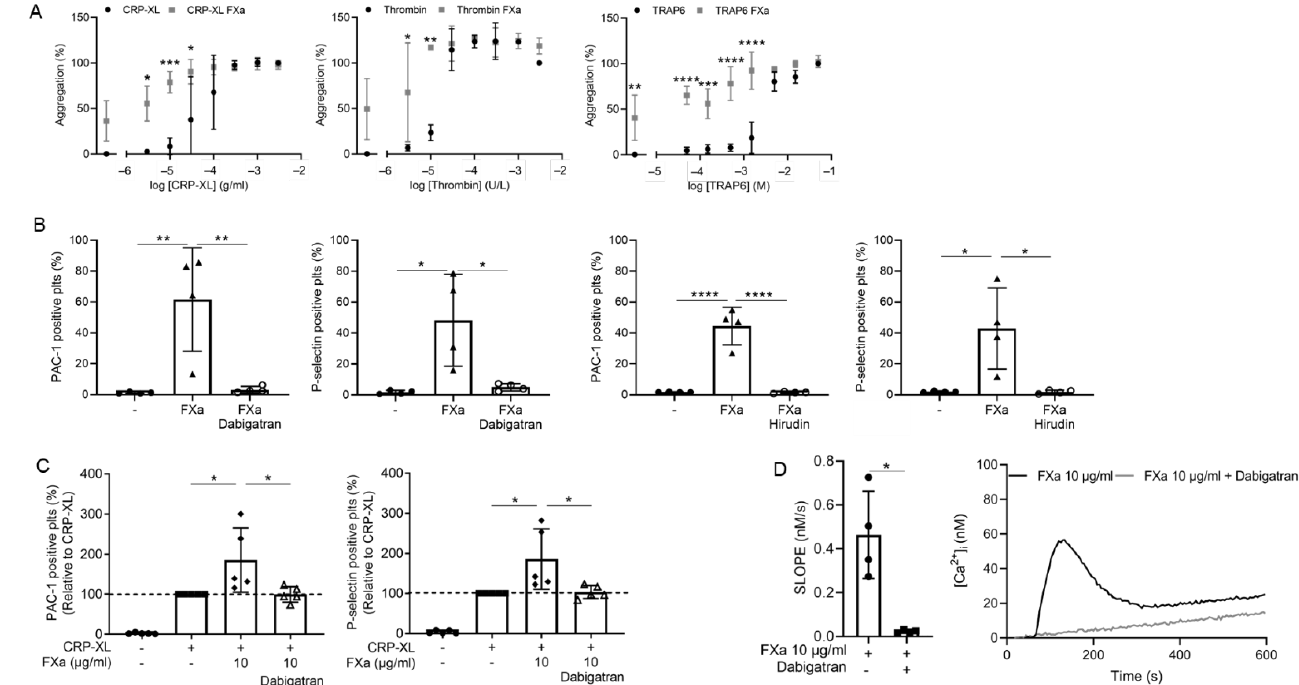
Figure 2. Factor Xa induces platelet activation and enhances agonist-induced platelet effects, in a thrombin-dependent way. ( A ) Factor Xa enhances agonist-induced platelet aggregation. Washed platelets preincubated with vehicle or FXa (10 µ g/mL) were stimulated with CRP-XL (0.003–3 µ g/mL), thrombin (0.003–3 U/mL) or TRAP-6 (0.05–50 µ M). Platelet aggregation was assessed by well plate-based light transmission changes. All data were scaled relative to aggregation obtained upon highest agonist concentration in the presence of vehicle (100%). Mean ± SD, n = 3; two-way ANOVA, * p < 0.05, ** p < 0.01, *** p < 0.001, **** p < 0.0001. ( B ) FXa-induced platelet activation is inhibitable by dabigatran or hirudin. Flow cytometry, washed platelets. Active integrin and P-selectin expression are shown. Percentage positive platelets. One-way ANOVA, multiple comparisons, mean ± SD, n = 4 – 5, one-way ANOVA, * p < 0.05 and ** p < 0.01, **** p < 0.0001. ( C ) Enhancement of CRP-XL-induced platelet activation by FXa is abolished by dabigatran. One-way ANOVA, multiple comparisons, data are compared to CRP-XL, * p < 0.05, mean ± SD, n = 4 – 5. ( D ) FXa-induced cytosolic Ca 2+ release is inhibitable by dabigatran. Washed platelets, loaded with Fura-2 acetoxymethyl ester (3 µ M). Changes in cytosolic [Ca 2+ ] I were measured using FlexStation 3. Outcome was assessed from slope of initial Ca 2+ rises and representative time traces. Unpaired t -test, * p < 0.05, mean ± SD, n =